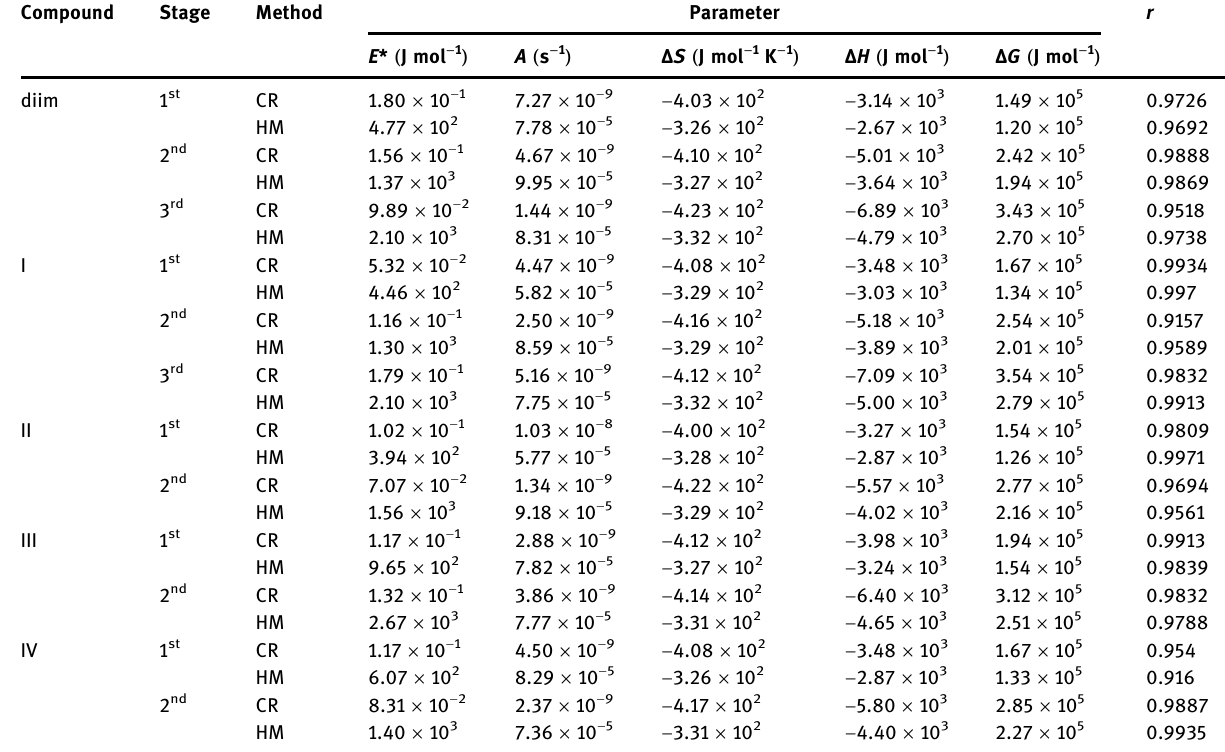
Table 4: Coats – Redfern ( CR ) and Horowitz – Metzger ( HM ) calculations for the methoxy - diim ligand and its metal complexes Compound Stage